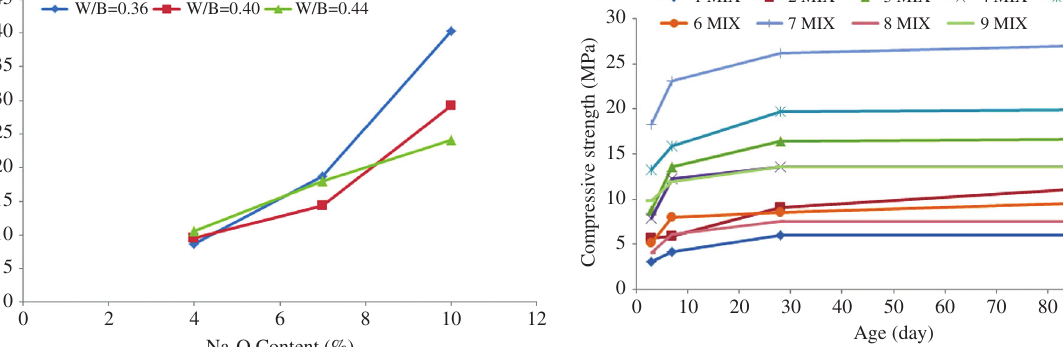
O on 28-day compressive strength for Figure 11 The effect of Na 2 samples cured at 65 ° C and constant w/b.